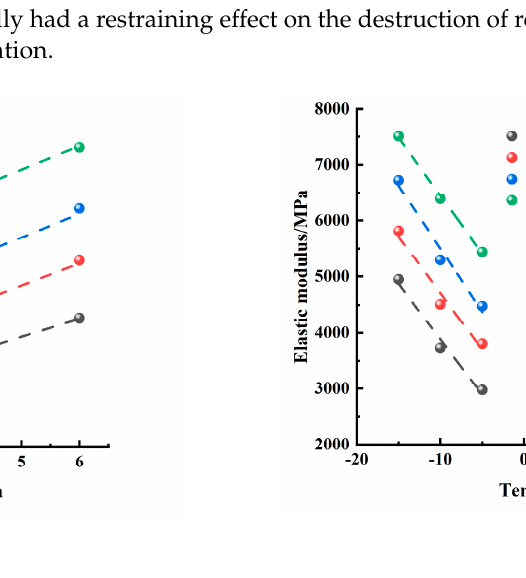
Figure 7. Sandstone elastic modulus and the relationship between confining pressure and temperature. ( a ) Relationship between elastic modulus and confining pressure. ( b ) Relationship between elastic modulus and temperature.